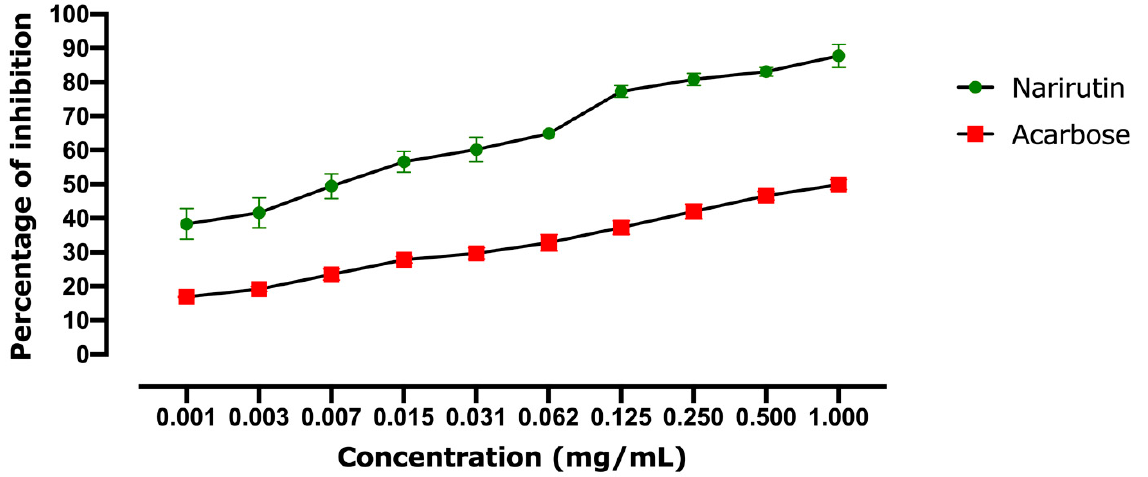
Figure 9. Alpha-amylase inhibitory effect results. Values are expressed as mean ± SD ( n = 3).